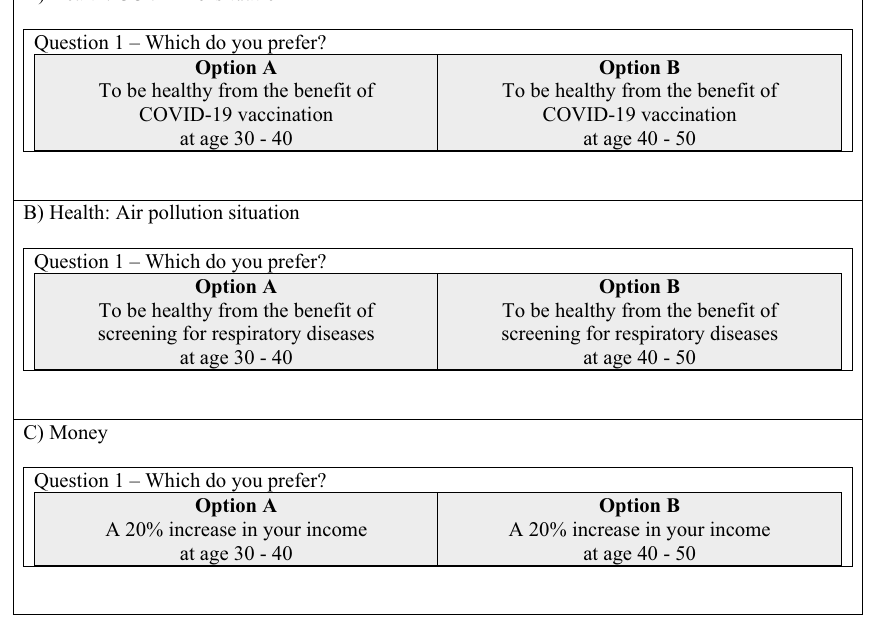
Figure 1. Example of questions about health and money. COVID-19, Coronavirus disease